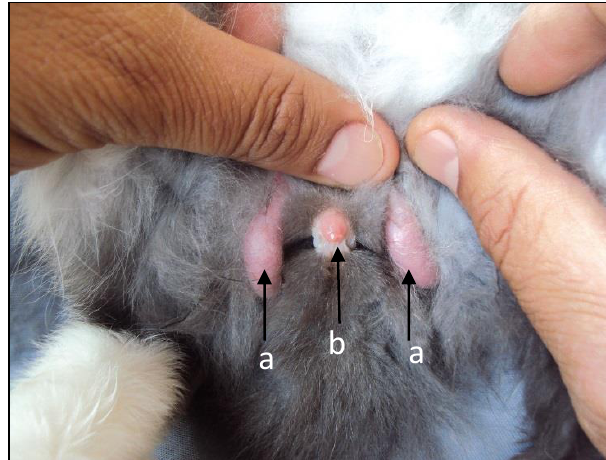
Figure, 11: Shows the perineal position of the testes in semi-pendulous scrotal sacs in the buck rabbit at 150 days old a- testis b-